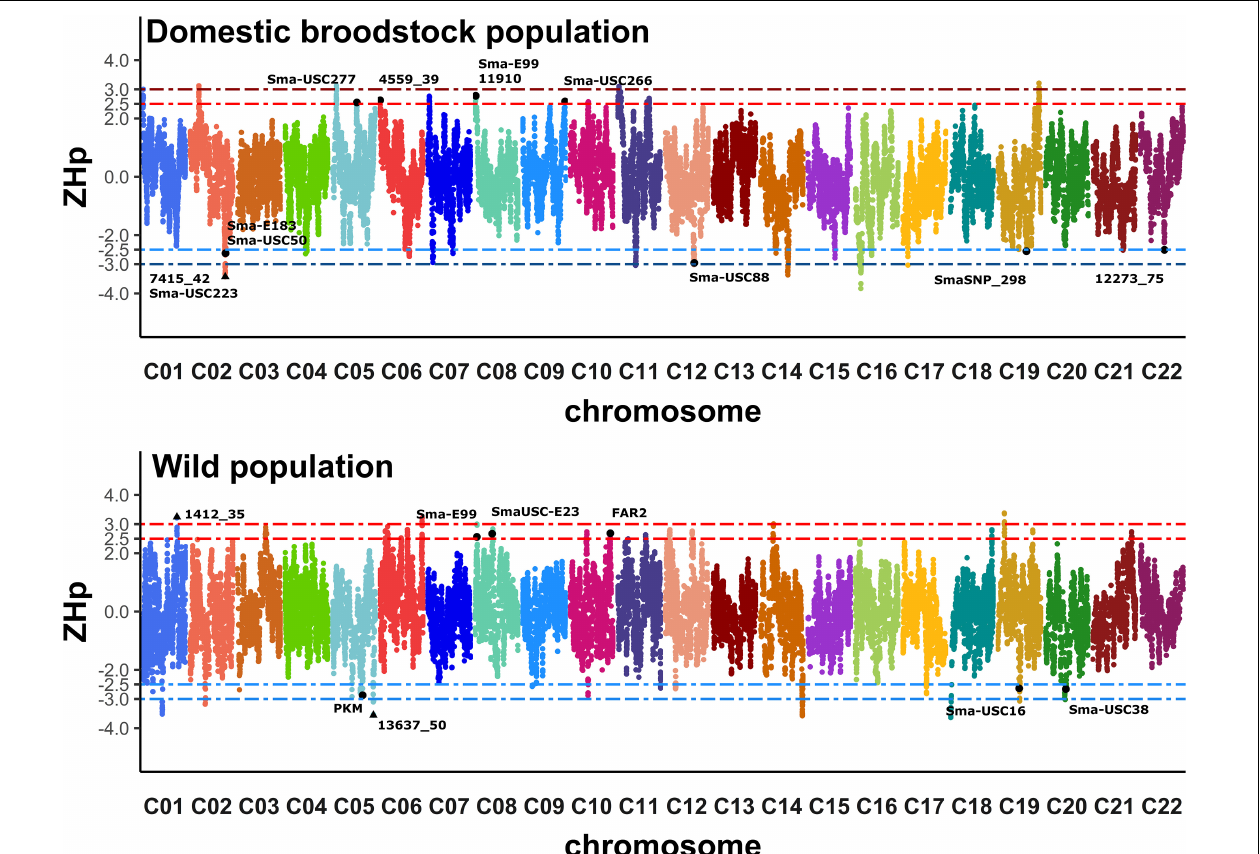
FIGURE 4 | Genome-wide distribution of Z-transformed pooled heterozygosity (ZHp) in the broodstock and wild populations. ZHp estimates were obtained using 37-SNP sliding windows (colored dots) across turbot chromosomes. ZHp thresholds are represented as dotted horizontal lines (ZHp > 2.5/3.0, red; ZHp < –2.5/3.0; blue). Relevant markers included inside strict low and/or high genetic diversity regions are displayed as black triangles; those inside suggestive low and/or high genetic diversity regions are displayed as black